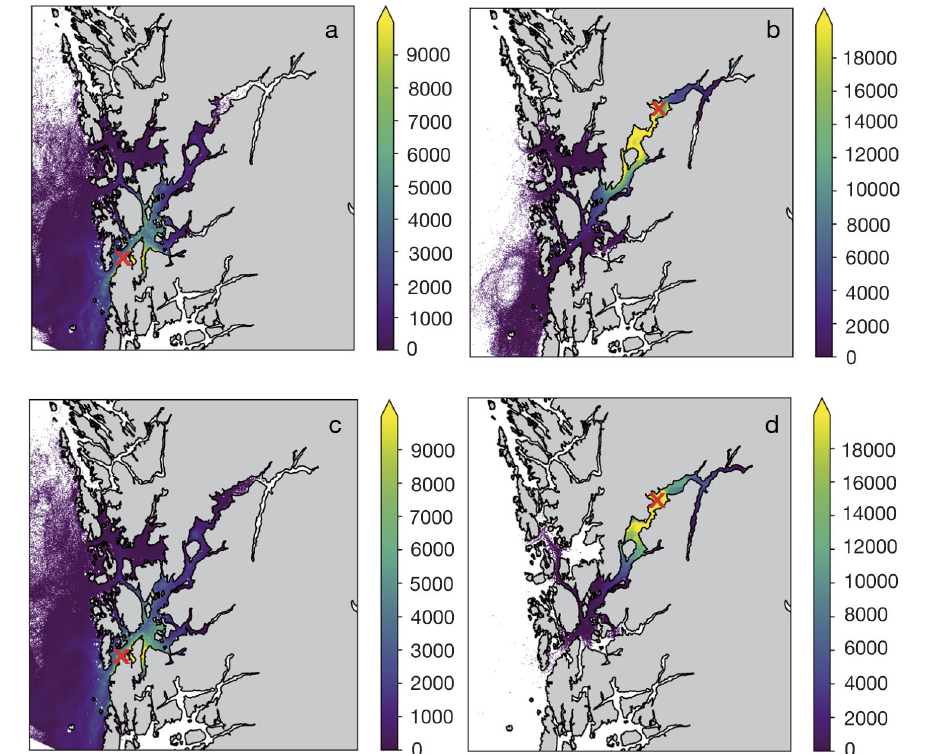
Fig. 4. Salmon lice particle density per model grid (160 × 160 m) on the southwest coast of Norway during May 2016. Red cross marks the position of particle release. Copepodid distribution after release from (a) a coastal site or (b) an inner fjord site using the existing dispersal model parameterisation of salinity avoidance by lice larvae at 20 ppt; (c) a coastal site or (d) an inner fjord site using the new dispersal model parameterisation with results from the present